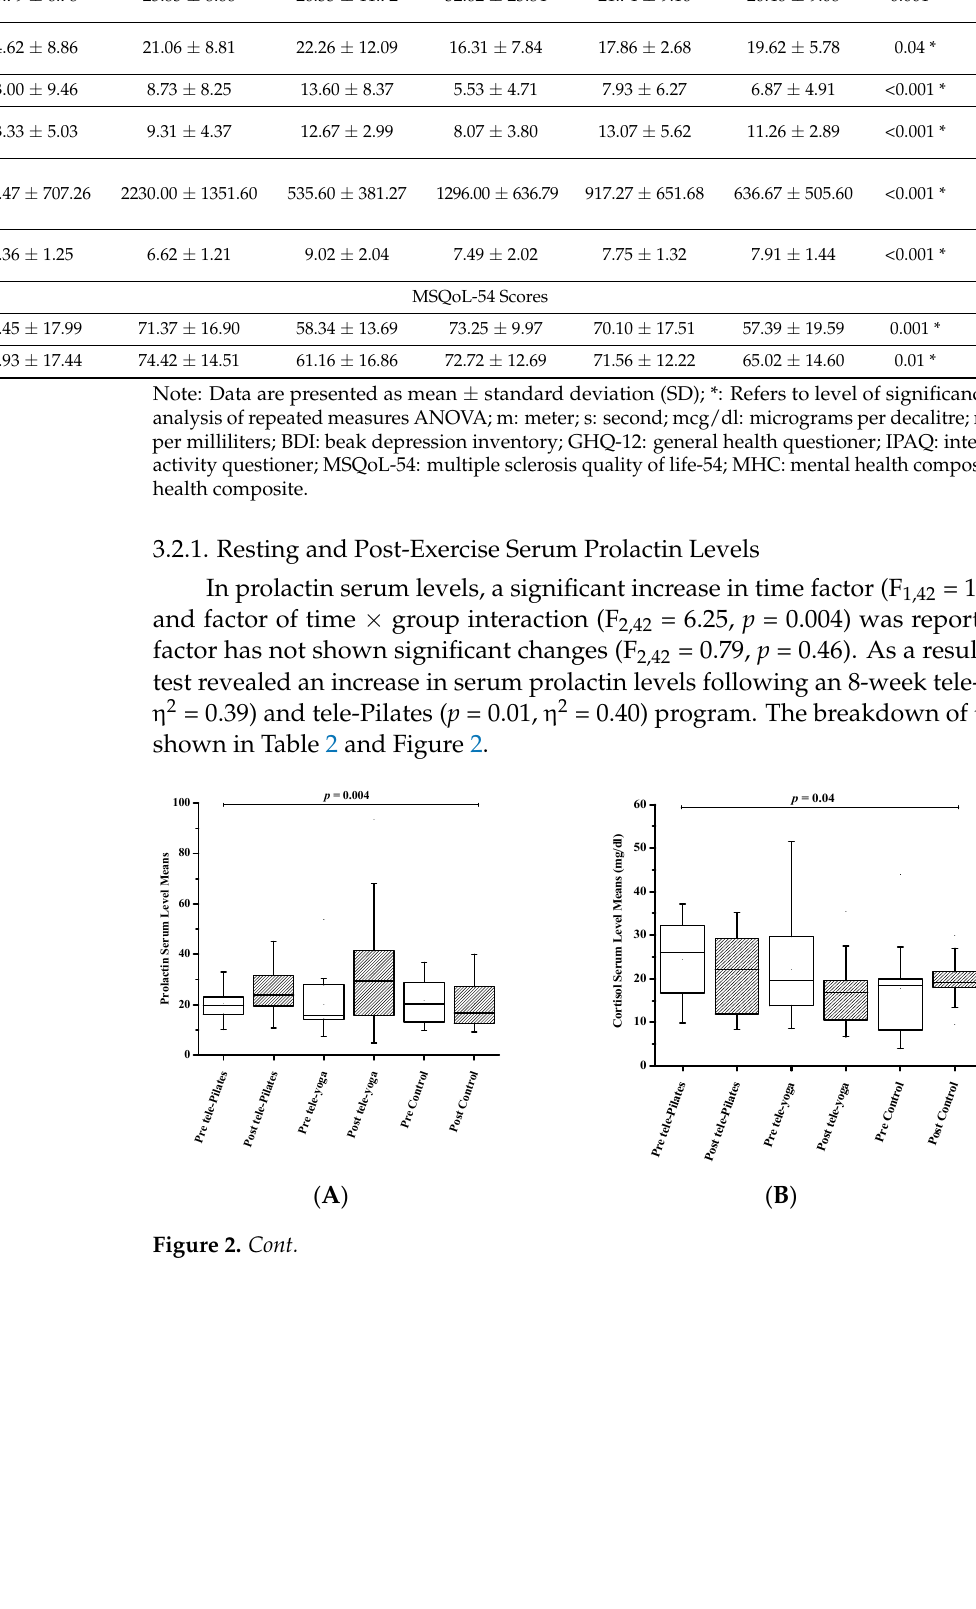
Table 2. Effects of 8 weeks of tele ‐ exercising in measurement scores.